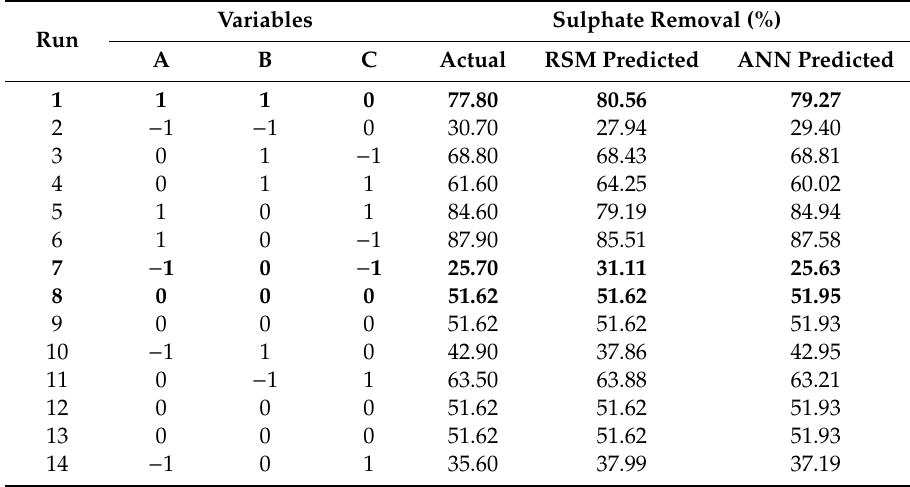
Table 2. Design matrix with actual and predicted response values via response surface methodology (RSM) and artificial neural network